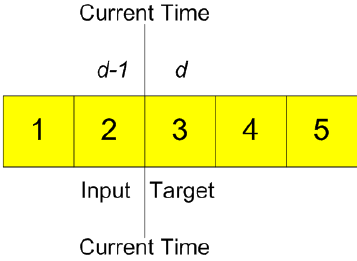
Figure 4. Philosophy raised for the learning phase and for the operation